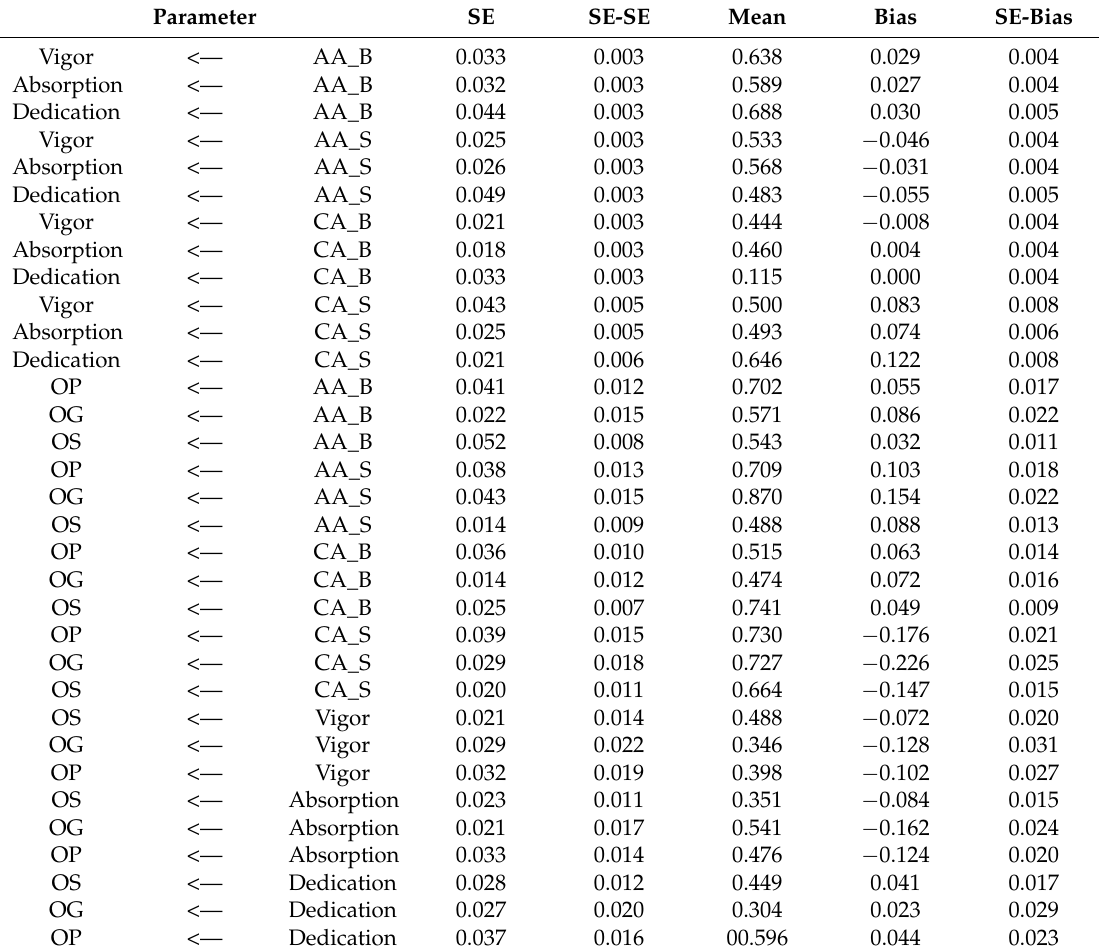
Table 16. Results of standardized regression